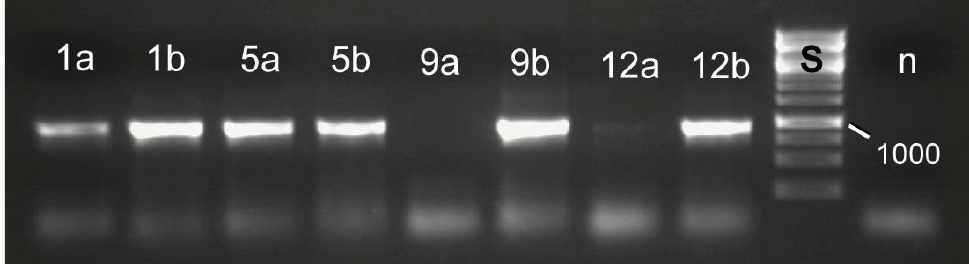
Figure 5. Molecular detection of symbiotic bacteria in larvae of Macroplea sp. from the tetracycline experiment, using specific PCR primers. Larvae of all four groups (tetracycline treated/control × free larvae/larvae from cocoon) contained symbiont DNA. Samples